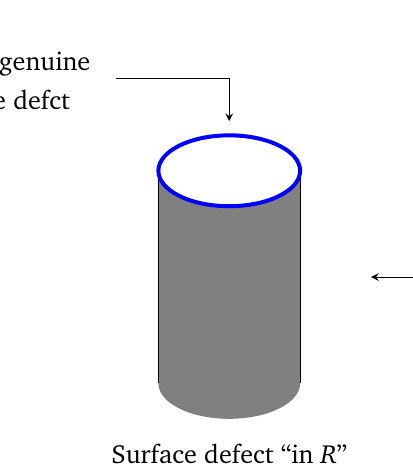
Figure 2: A surface defect ending at a non-genuine line defect in the 6 d theory leads to, upon circle compactification, to a gauge Wilson line defect ending at a non-gauge- invariant local operator in the 5 d theory. Equivalently, a gauge Wilson line defect ending at a non-gauge-invariant local operator in the 5 d theory lifts in the 6 d theory to a surface defect ending at a non-genuine line defect compactified along the